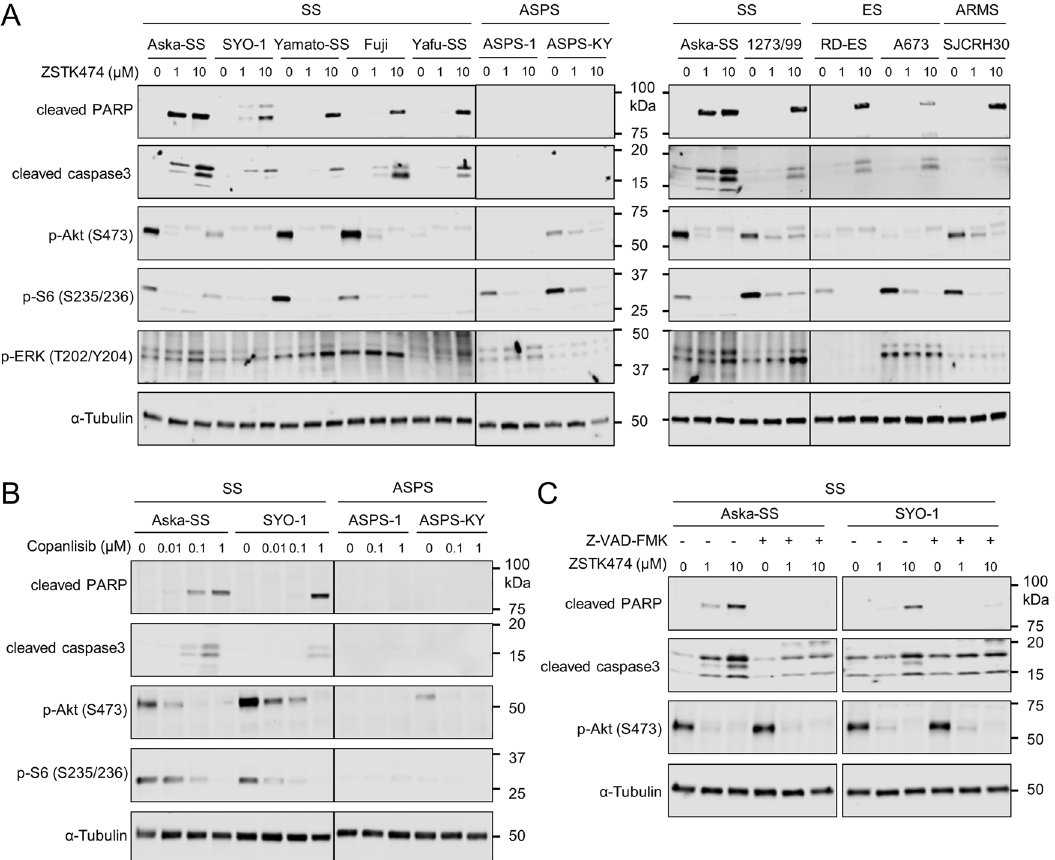
Fig. 1 Treatment with PI3K inhibitors induced apoptosis in translocation-related sarcomas (TRSs) including synovial sarcoma (SS), Ewing ’ s sarcoma (ES) and alveolar rhabdomyosarcoma (ARMS) but not alveolar soft part sarcoma (ASPS). A , B Effects of the PI3K inhibitors ZSTK474 ( A ) and copanlisib ( B ) on PI3K signaling and apoptosis in the indicated TRS cell lines. TRS cells were treated with ZSTK474 or copanlisib at the indicated concentrations for 48 h. Lysed samples were immunoblotted to detect the phosphorylation of signal molecules including Akt (Ser473), S6 (Ser235/236) and ERK (T202/Y204) and the expression of apoptosis markers including cleavage of PARP and activation of caspase3 and α -Tubulin. C The effect of ZSTK474 on PI3K signaling and apoptosis in Aska-SS and SYO-1 upon treatment with Z- VAD-FMK. Aska-SS and SYO-1 cells treated with or without Z-VAD-FMK at 40 μ M were treated with ZSTK474 at the indicated concentrations for 48 h. Lysed samples were immunoblotted to detect the phosphorylation of Akt (Ser473), cleavage of PARP, activation of caspase3 and expression of α -Tubulin. These experiments were performed independently at least two times with similar